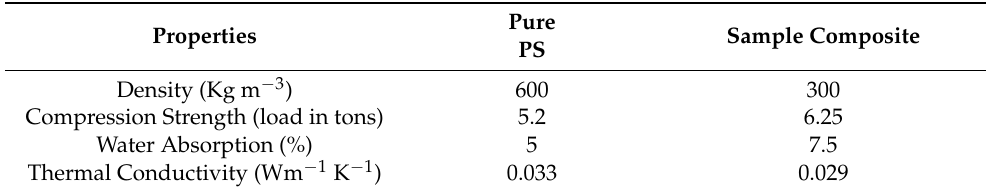
Table 3. Mechanical and physicochemical properties of PS and sample composite. Adapted with permission from ref. [70].